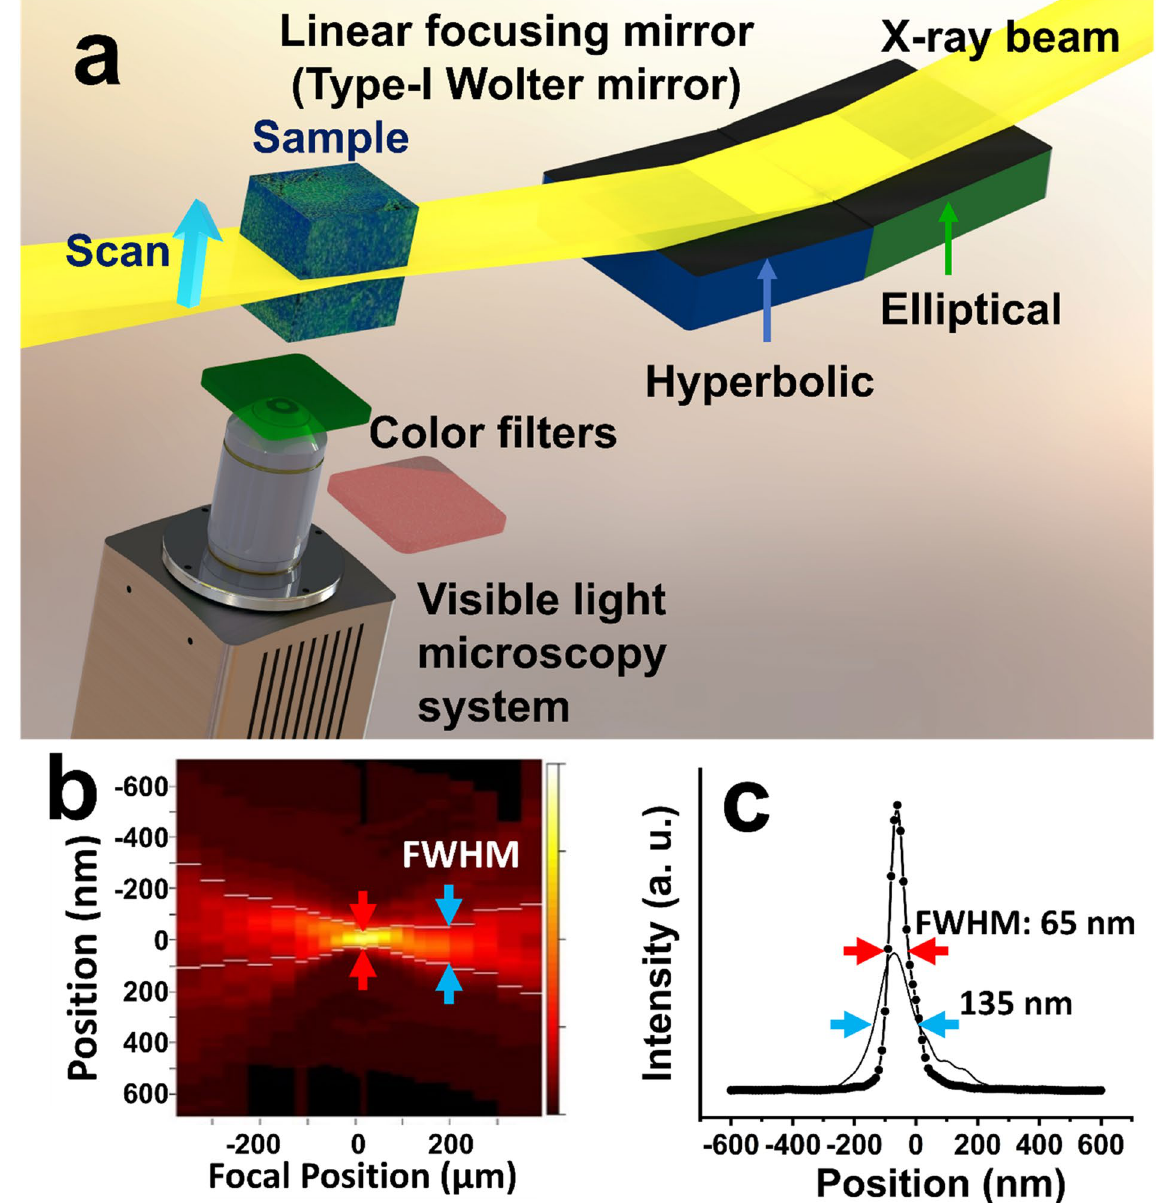
nanoparticles. ( b ) Knife edge intensity measurements performed at different positions along the optical axis. The measured thickness of the nanoplane was < 130 nm over the depth of focus of ± 175 µm. ( c ) A minimum FWHM size of 65 nm was observed at the focal